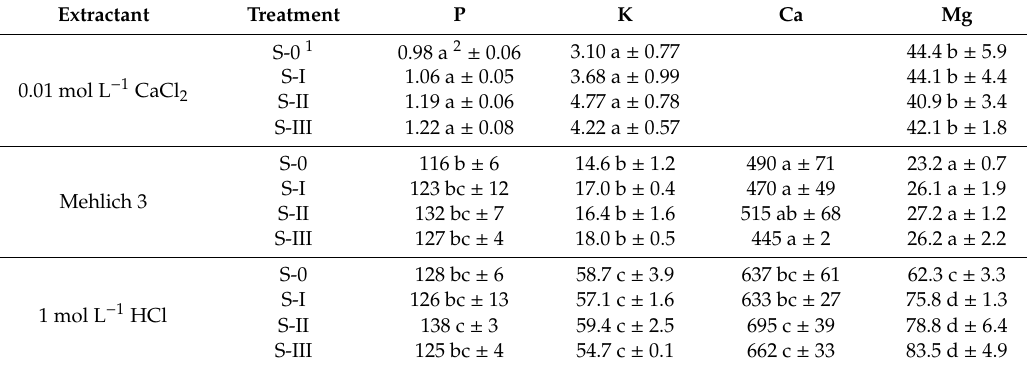
Table 4. Content of available forms of selected macroelements in light soil 60 days after